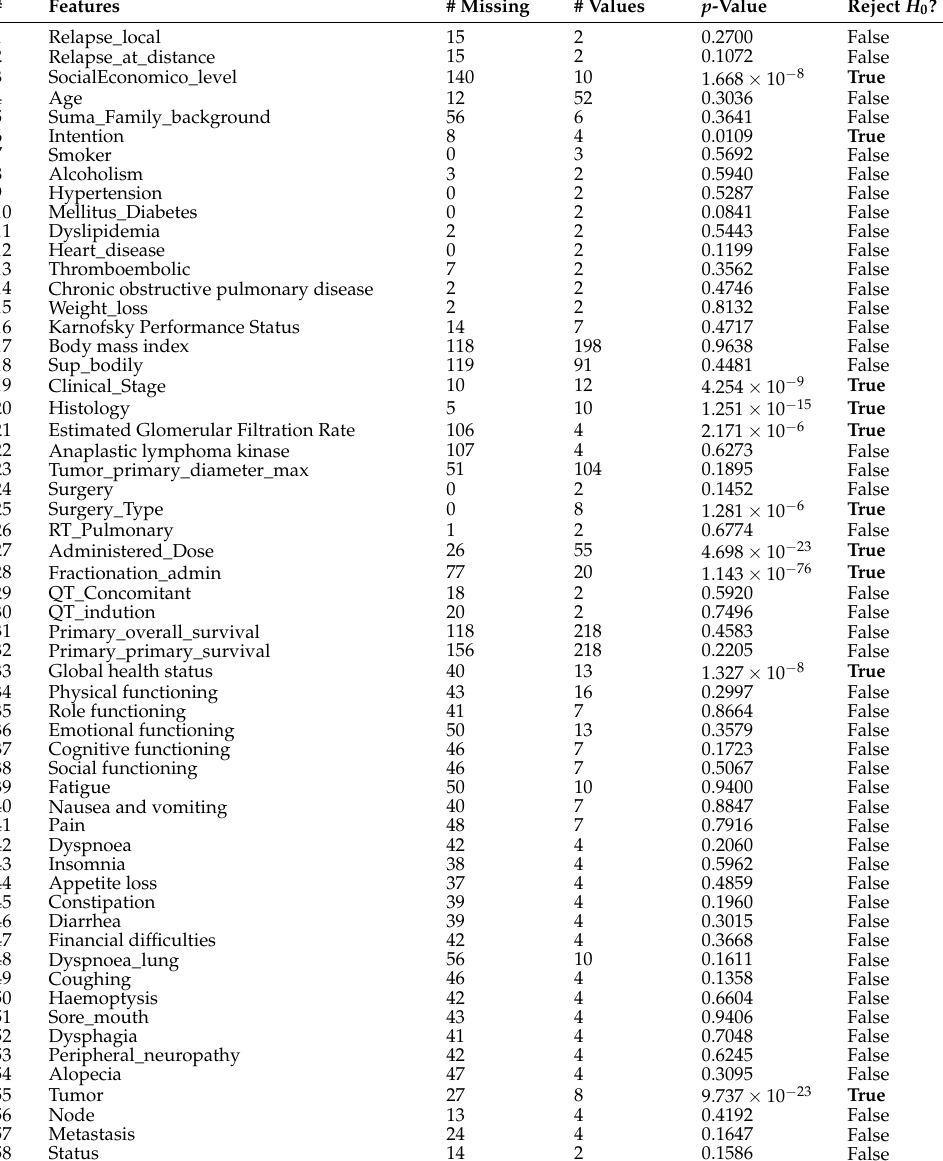
Table 3. Features: number of missing, number of different values, p -value and decision on rejecting the goodness-of-fit tests between real and fake data. Symbol # stands for